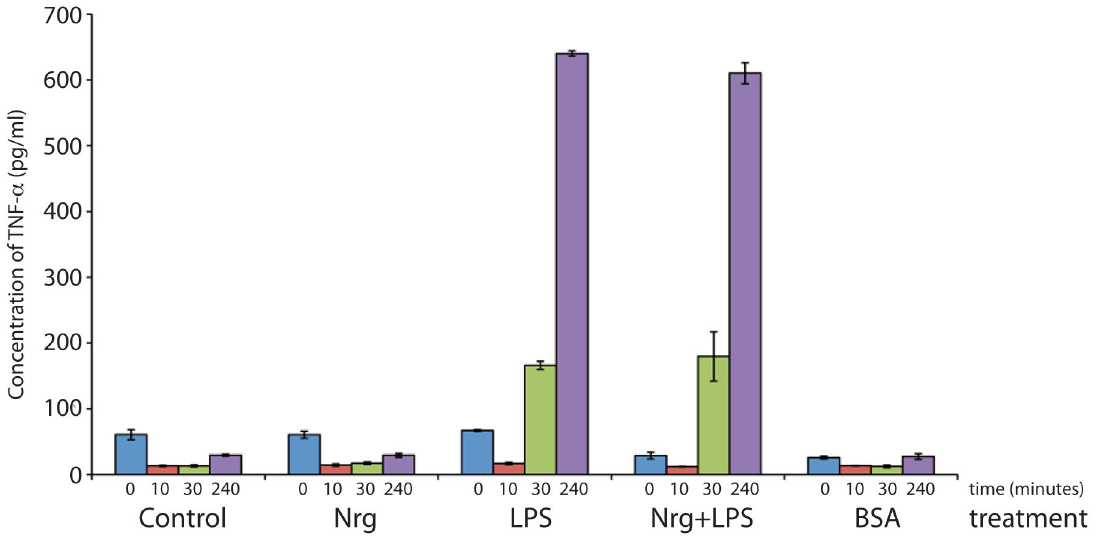
Figure 3. NRG does not affect TNF-α synthesis in macrophages. RAW 264.7 cells were challenged with LPS and the resulting induction of TNF-α determined at several time points. TNF-α concentrations were determined using cell culture media post- treatments by a commercially available ELISA kit. An additional treatment completed with BSA was added as a control for the experiment. Here we show that NRG addition 24 hours prior to LPS did not have an effect on TNF-α concentration in culture media, 610±15.98pg/mL, compared to LPS alone, 640±4.04pg/mL. These results suggest that, at least acutely, NRG alone does not